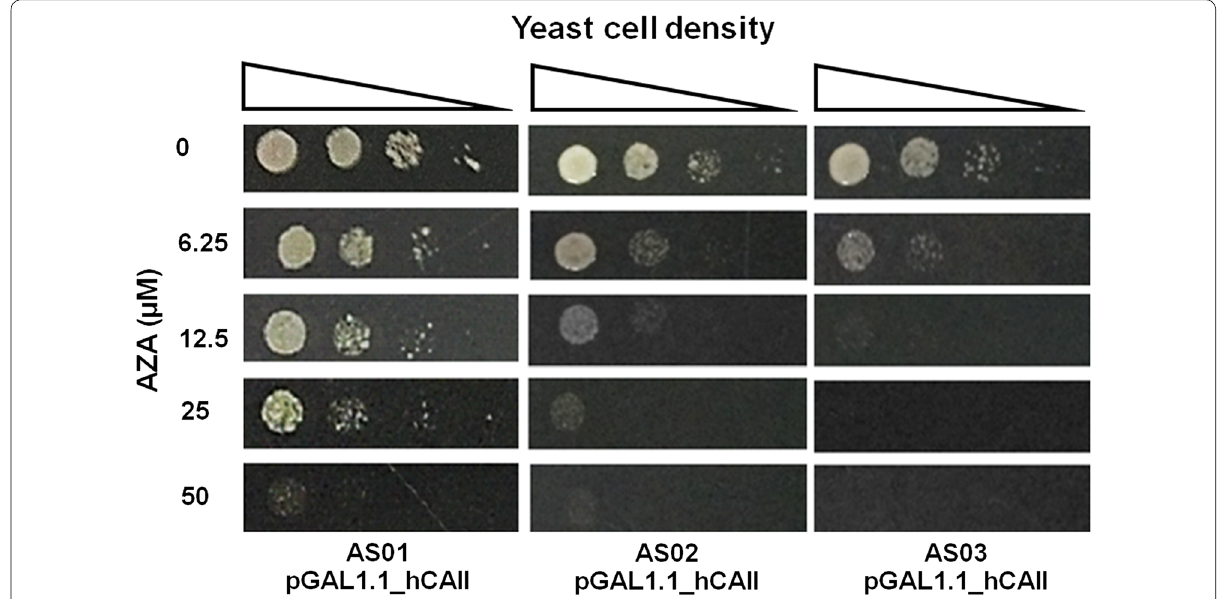
Fig. 2 Comparision of the drug-sensitivity phenotype of various NCE103 null mutant yeast strains. The AS01, AS02 and AS03 cells harboring the pGAL1.1_hCAII plasmid at concentrations of 10 6 , 10 5 , 10 4 and 10 3 cells mL − 1 were spotted onto the surface of SG